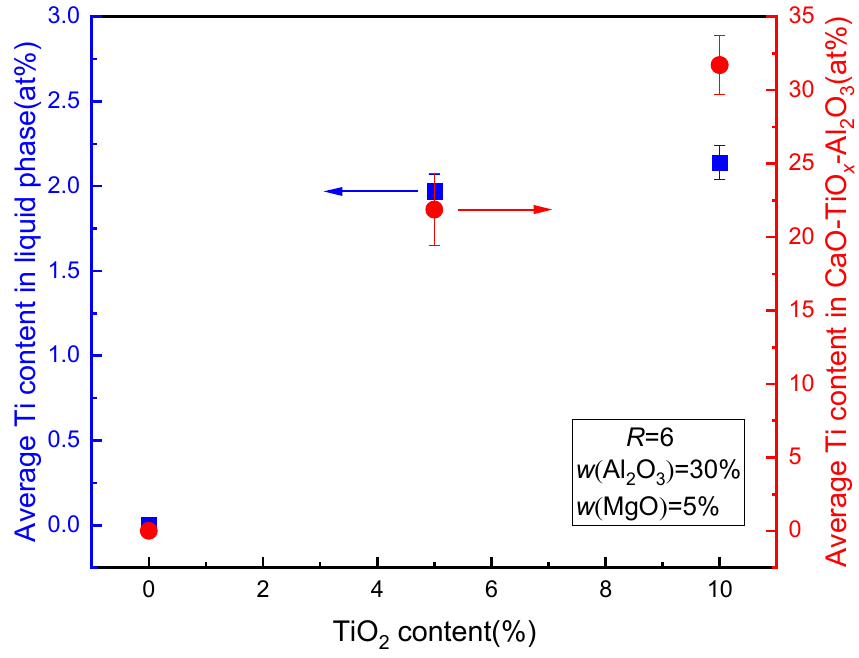
Figure 12 further plots the average atomic fractions of Ti element in the liquid and CTA phases of these slags with TiO 2 addition. It is shown that with the increase in TiO 2 content in the slags, the TiO x contents in both liquid and CTA phases increase, as well. Of note, when the TiO 2 content is higher than 5%, the increasing trend becomes very weak in the liquid phase. In contrast, the TiO x content increases evidently in the CTA phase.